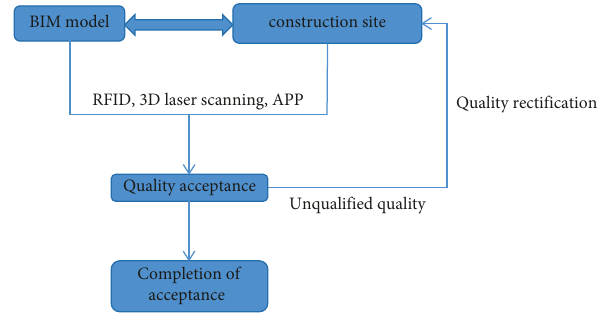
Figure 7: Quality